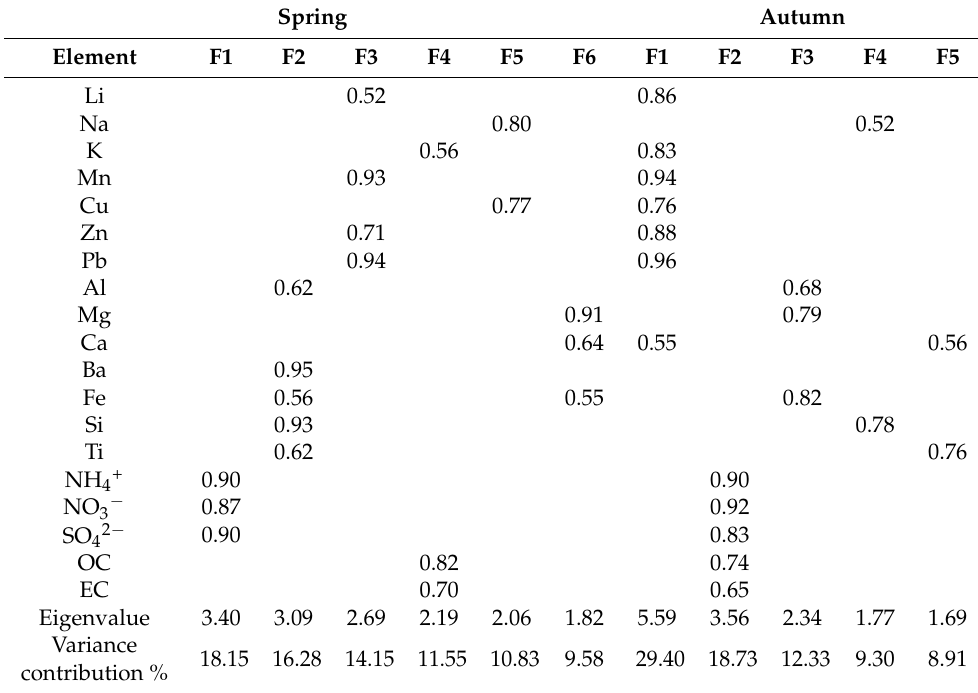
Table 2. Matrix of loading factors of PCA in spring and autumn.